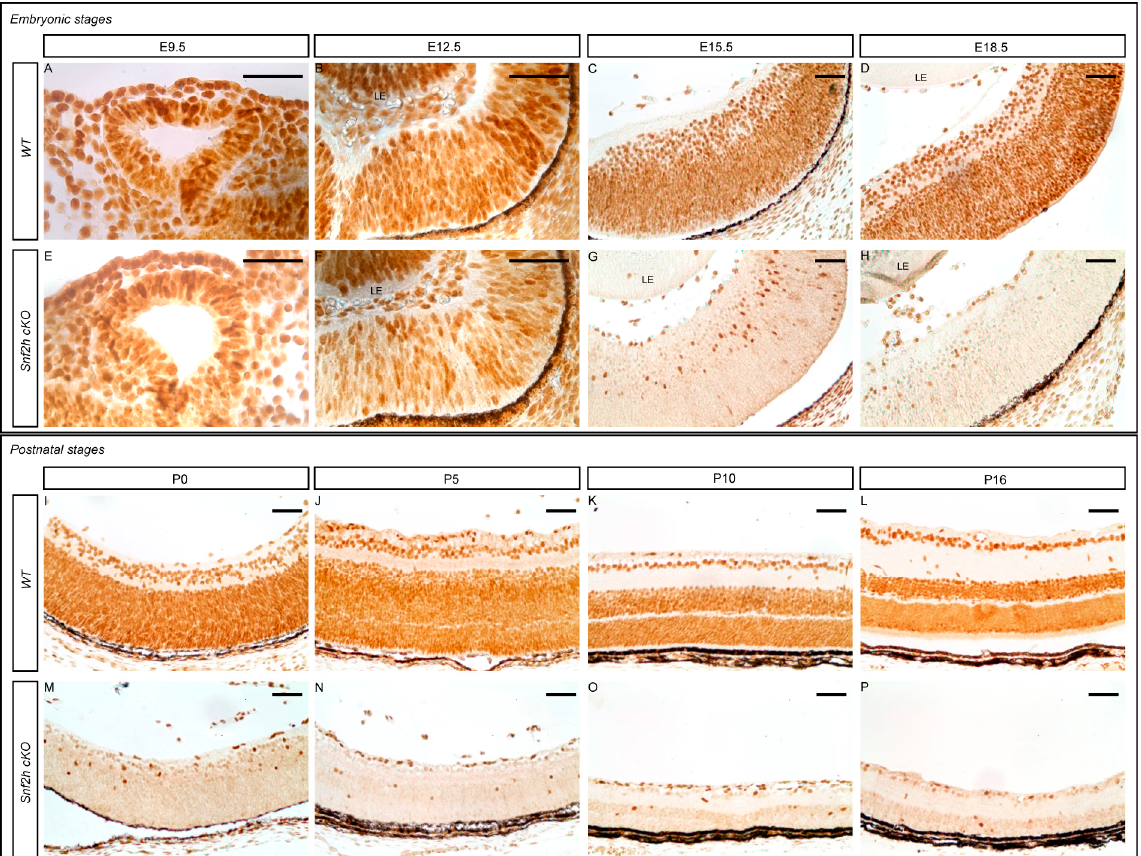
Figure 1. Snf2h expression during retina development. Immunohistochemistry staining of wild-type and mRx-Cre; Snf2h fl/fl ( Snf2h cKO) mice was carried out with anti-Snf2h specific antibodies in different embryonic and postnatal stages. Snf2h started to be expressed in early embryonic stages and was maintained in wild-type individuals throughout embryonic development, and in adulthood in both retinal progenitors and differentiated retinal cells ( A – D , I – L ). A decrease in Snf2h levels was first observed in E12.5 conditionally mutant retinae ( A , B , E , F ). During the following embryonic stages, a rapid reduction in Snf2h-positive cells in Snf2h cKO eye sections occurred ( G , H ), and only a few Snf2h-positive cells were found in Snf2h cKO at the postnatal stage ( M – P ). LE–lens. Scale bars: 50 µm.